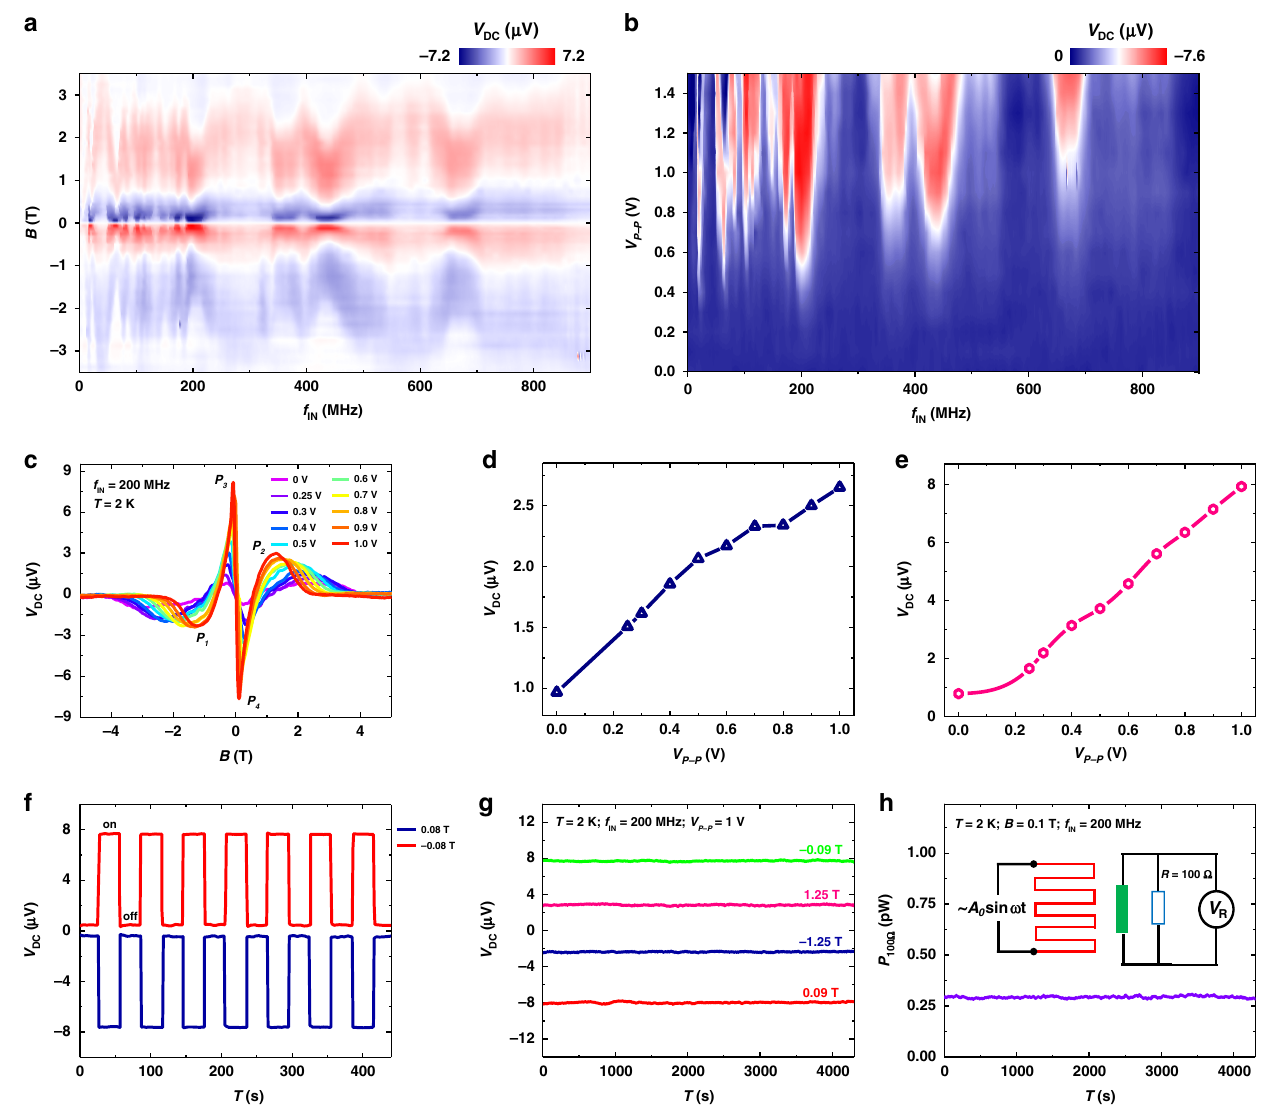
Fig. 5 Manipulating nonreciprocal sensitivity in NbSe 2 antenna. a , Color plot of V DC as a function of the frequency f IN and magnetic fi eld of the NbSe 2 antenna device at V P-P = 1 V and T = 2 K. The NbSe 2 thickness is fi ve layers. b , Color plot of V DC as a function of frequency f IN and V P-P of the device at B = 0.12 T and T = 2 K. c , V DC -B of the device with V P-P value (that is, the power of the AC signal applied on the resistor) changing from 0 to 1 V at T = 2 K, f IN = 200 MHz. V P 1 -V P 4 are the peak values of V DC . d , e , Extracted V MAX1 and V MAX2 value as a function of V P-P value, where V MAX 1 ¼ V P 1 (cid:1) (cid:1) (cid:1) (cid:1) (cid:1)(cid:6) (cid:7) (cid:1) (cid:1) þ V (cid:1) ¼ V V = 2. Both V MAX1 and V MAX2 values increase monotonically as the increase of V P-P value. f , The dynamic behavior of the device with MAX 2 P 3 P 4 the AC signal ( f IN = 200 MHz, V P-P = 1 V) switching on and off at B = 0.08 T and − 0.08 T, respectively. g , Retention behavior o f the device under various magnetic fi elds with a frequency of f IN = 200 MHz, and V P-P = 1 V at T = 2 K. h , Time evolution of the generated power of a 100 Ω resistor connected to the device ( B = 0.1 T, f IN = 200 MHz, V P-P = 1 V, T = 2 K), showing a stable detection after 4300 s. Inset, a schematic circuit diagram of the measurement of the generated power on a 100 Ω resistor connected to the